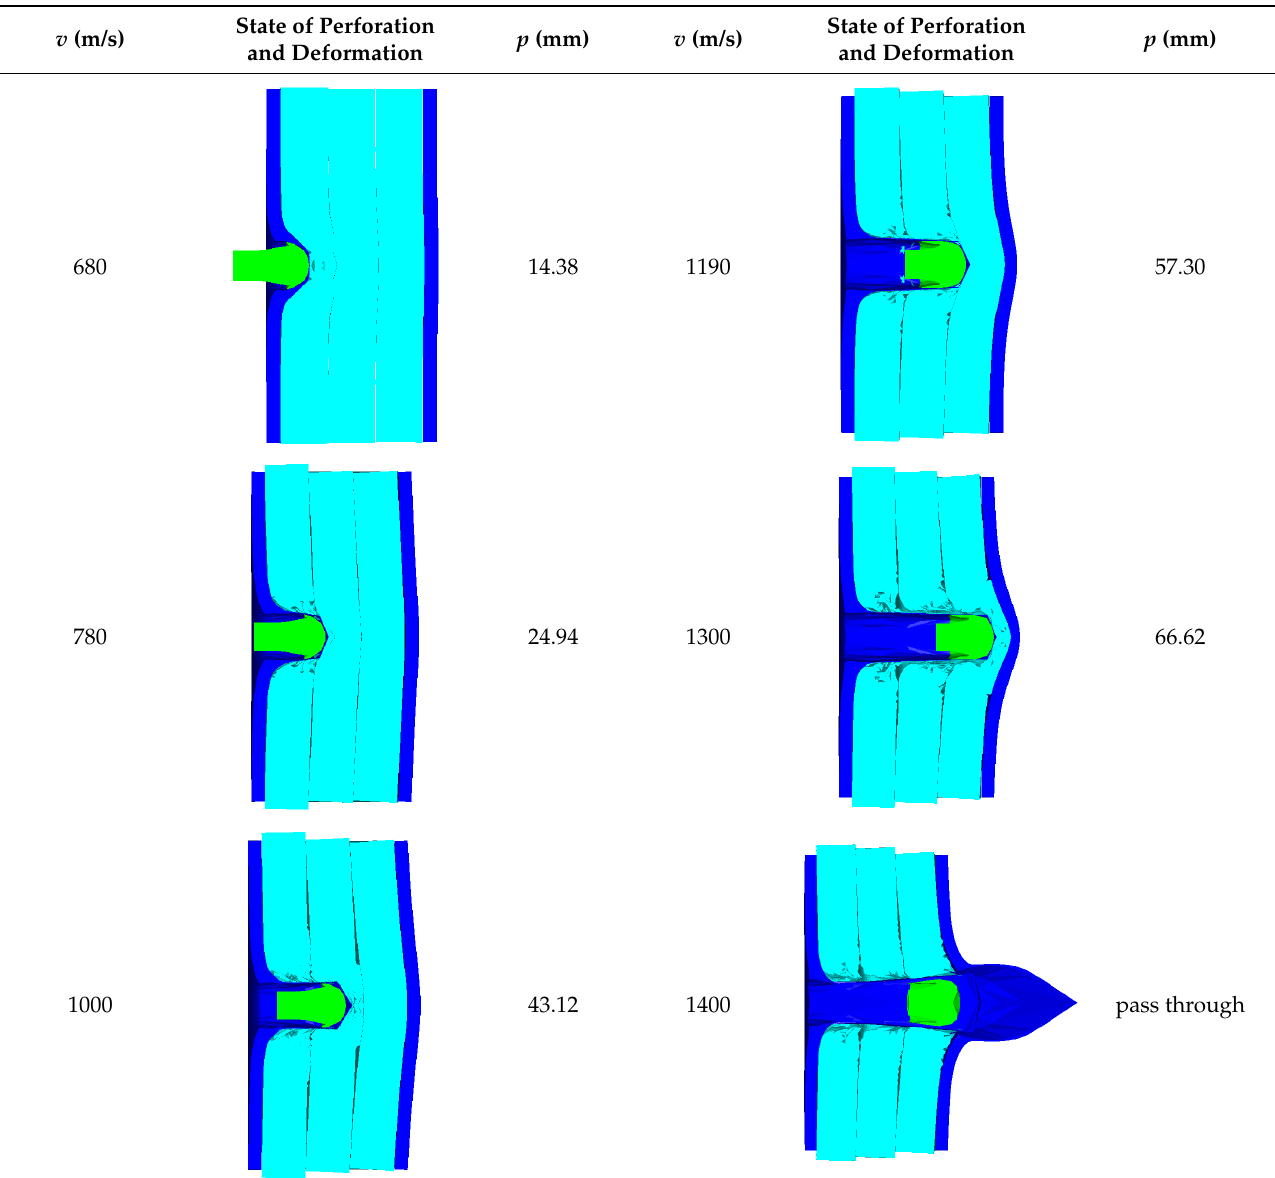
Table 8. Numerical simulation results of projectile penetrating armor with three layers of PE.